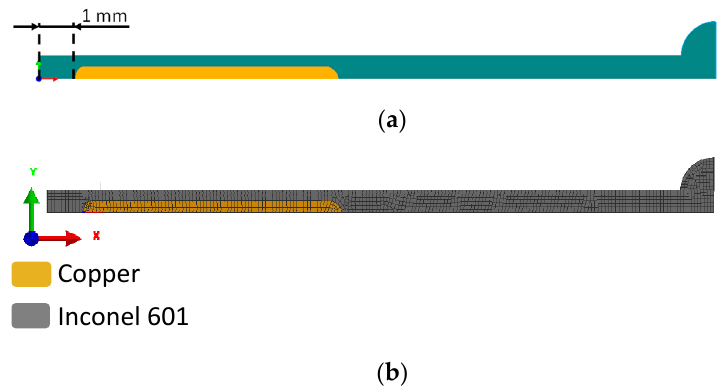
Figure 14. ( a ) New geometry design, and ( b ) finite element meshes for generalized plane strain model.